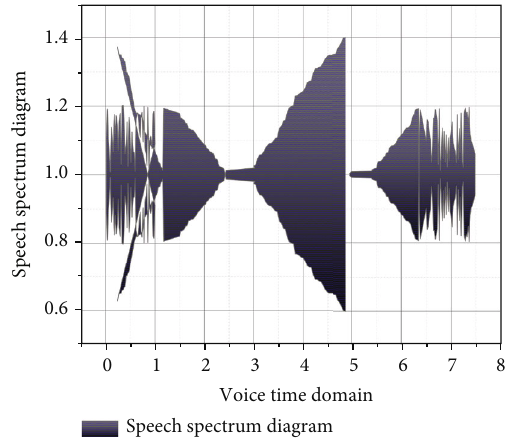
Figure 1: Speech time-domain map and speech spectrum